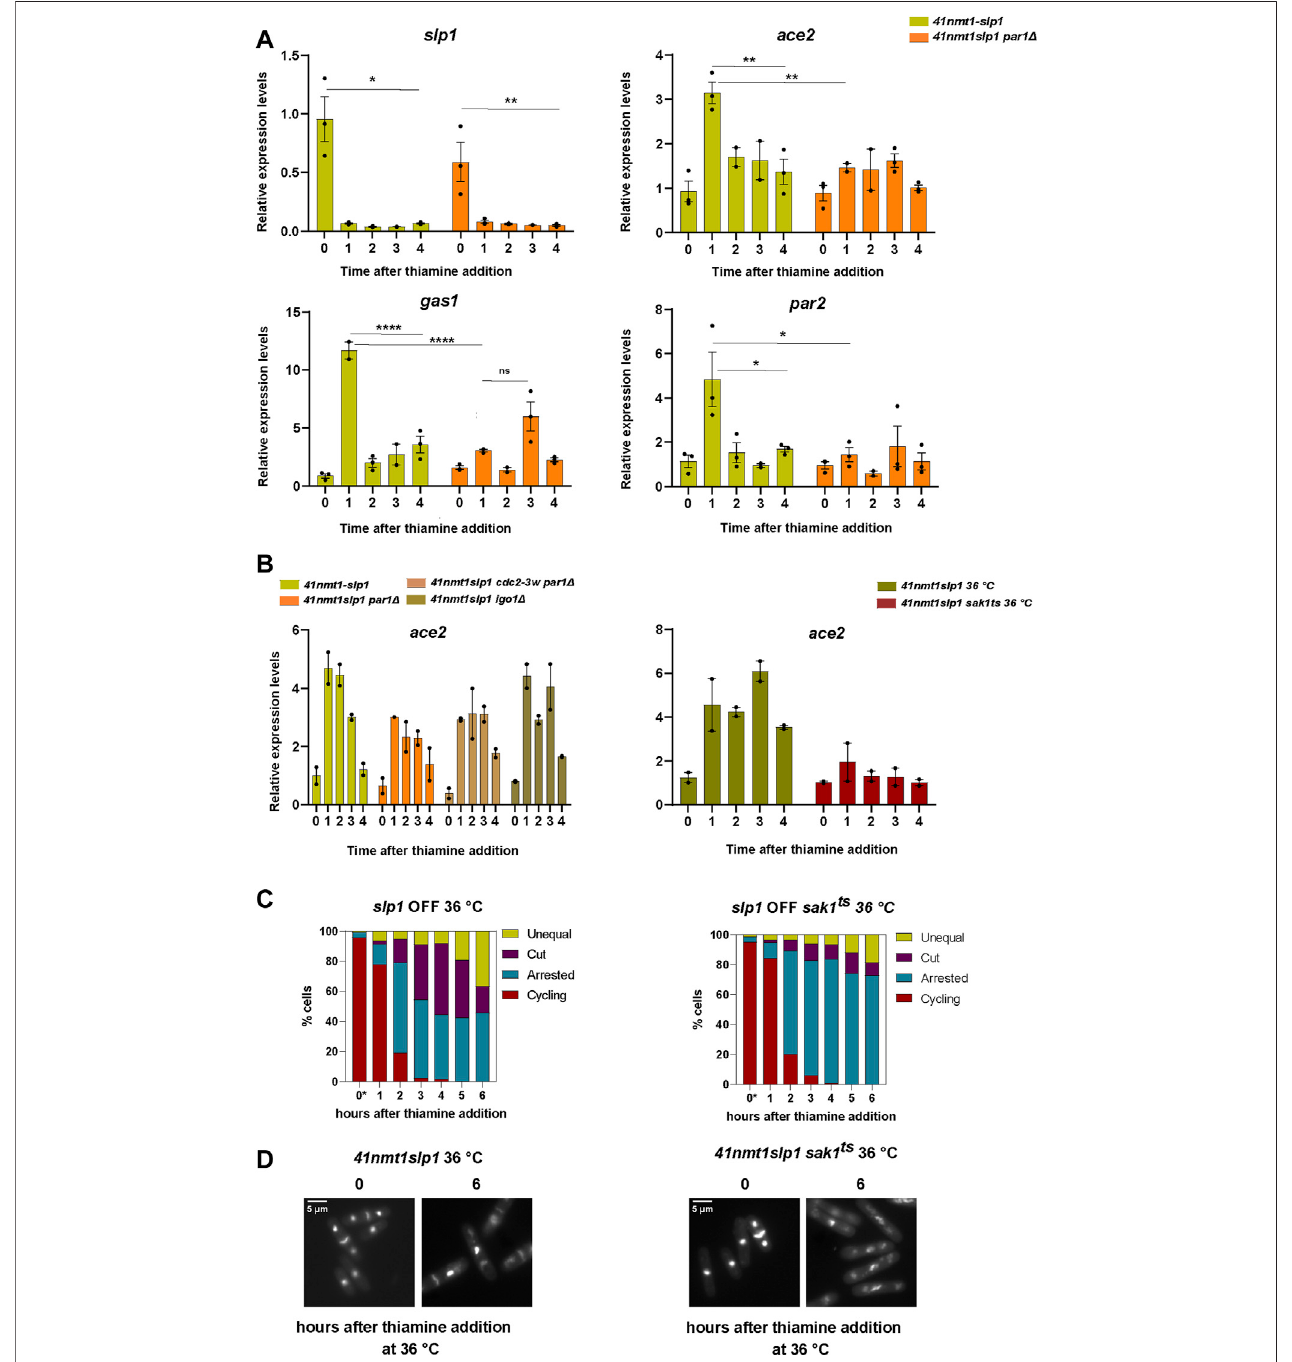
FIGURE7| Themitotictranscriptionalwavein fl uencesthebehaviourofcellsarrested inmetaphase. (A – D) CellsweregrownexponentiallyinEMMat30 ° Cor25 ° C ( p41-nmt1 promoter induced) and shifted to EMM +T ( p41-nmt1 promoter repressed) at 30 ° C or 36 ° C. Samples were collected at the indicated time points for mRNA expressionandmicroscopy. (A) mRNAexpressionof slp1,ace2,gas1andpar2 inwildtypeandin p41-nmt1:slp1orp41-nmt1:slp1par1 Δ cells.Expressionisrelativeto actin and was determined by qPCR. Mean and SEM of three biological replicate are shown. Statistical signi fi cance was determined by a two-way ANOVA with Tukey ’ s multiple comparisons test. ns: p > 0.05; *: p ≤ 0.05; ** ≤ 0.01; ****: p ≤ 0.0001. (B) Left panel. mRNA expression of ace2 in p41-nmt1:slp1 or p41-nmt1:slp1 par1 Δ , p41-nmt1:slp1 cdc2-3w par1 Δ and p41-nmt1:slp1 igo1 Δ cells. Expression is relative to actin and was determined by qPCR. Mean and SEM of at least two biological replicates are shown. Right panel. mRNA expression of ace2 in p41-nmt1:slp1 or p41-nmt1:slp1 sak1ts cells. Expression is relative to actin and was determined by qPCR. Mean and SEM of at least two biological replicates are shown. (C) The percentage of cycling cells, metaphase-arrested cells, and arrested cells that underwent cytokinesis (cut or unequal) in p41-nmt1:slp1 (left panel) and p41-nmt1:slp1 sak1ts (right panel) at each indicated time point after thiamine addition. (*) cells grown at 25 ° C. At least 200 cells were counted per time point. (D) Representative images of mitotic features distributions from DAPI and Blankophor-stained ethanol- fi xed cells in (C) . Scale bar 5 µm.